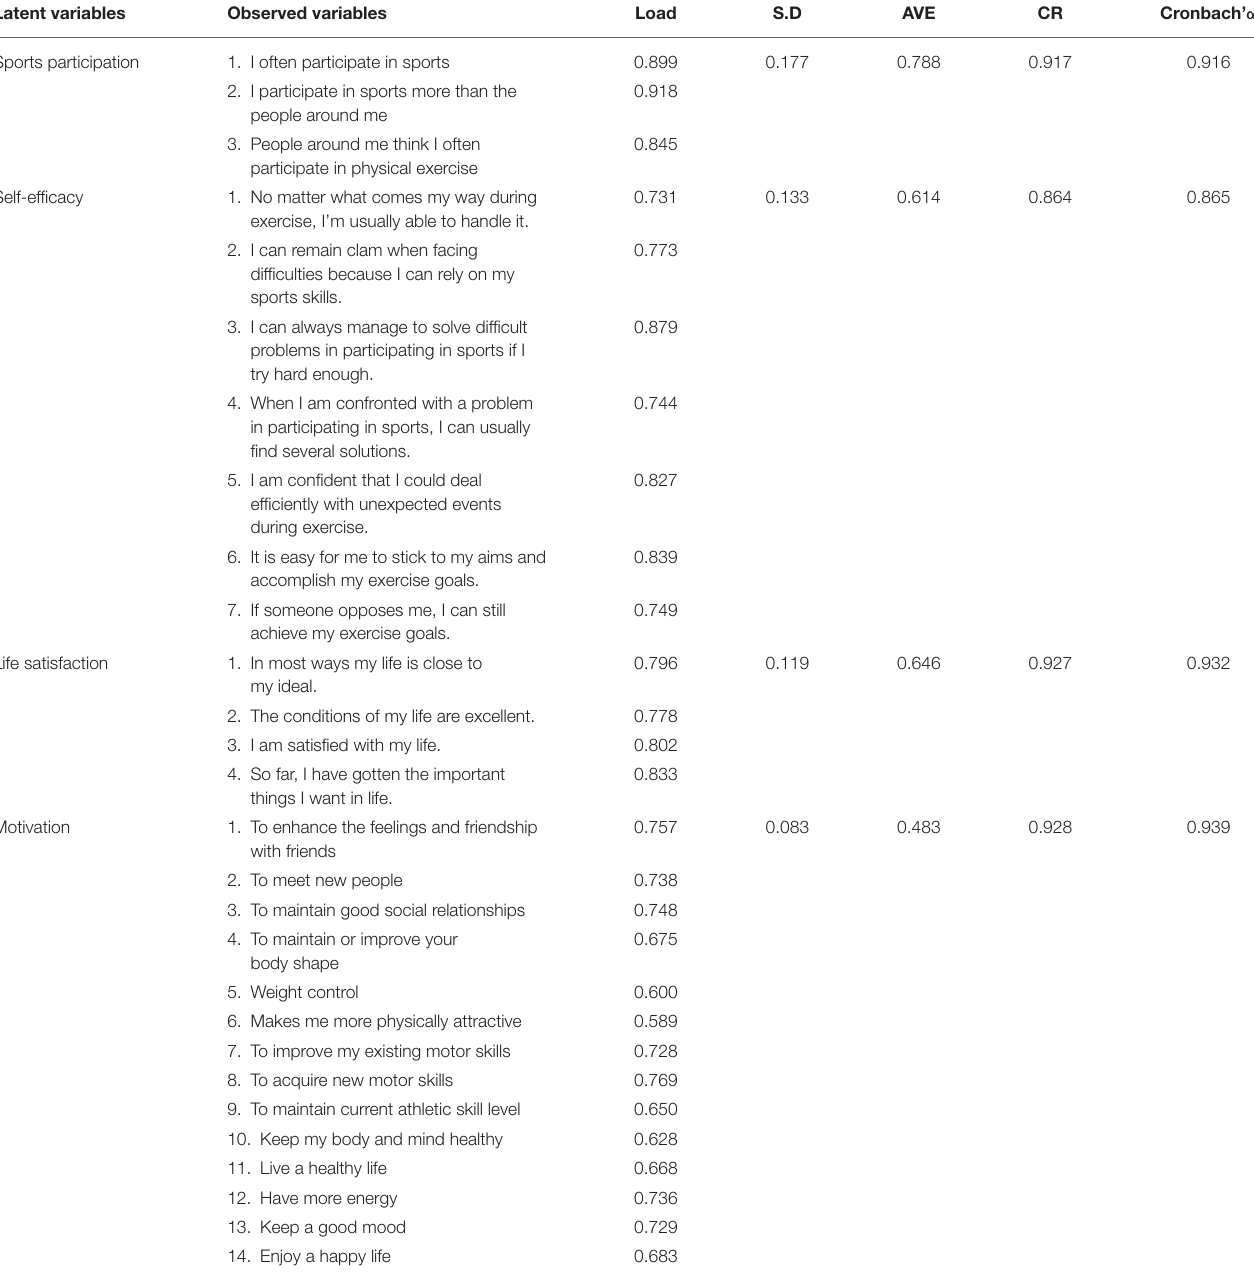
TABLE 2 | Loads, standard deviations, reliability estimates, and convergent validity